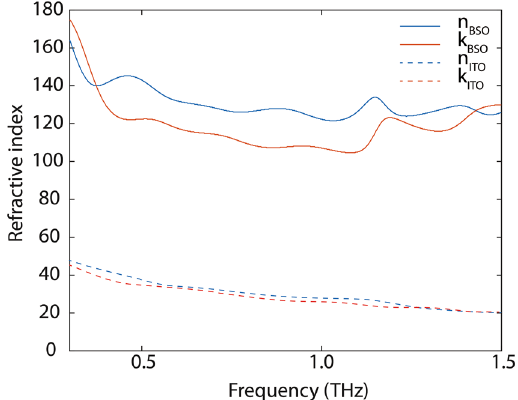
Figure 3. Real ( n ) and imaginary ( k ) part of refractive index vs. frequency for Sample #1 . These parameters are directly extracted from the complex TDS transmission. In addition to the extracted values for our La-doped BSO sample (49 nm thick film), data reported in the literature 9 for an ITO film (345 nm thick) is also depicted in the plot. In both cases, a metal-like response is observed. The conductivity levels observed in the analyzed BSO samples are on par with the best results reported in the literature for ITO 29 , and larger than those for the samples studied by terahertz spectroscopy in ref. 9 .